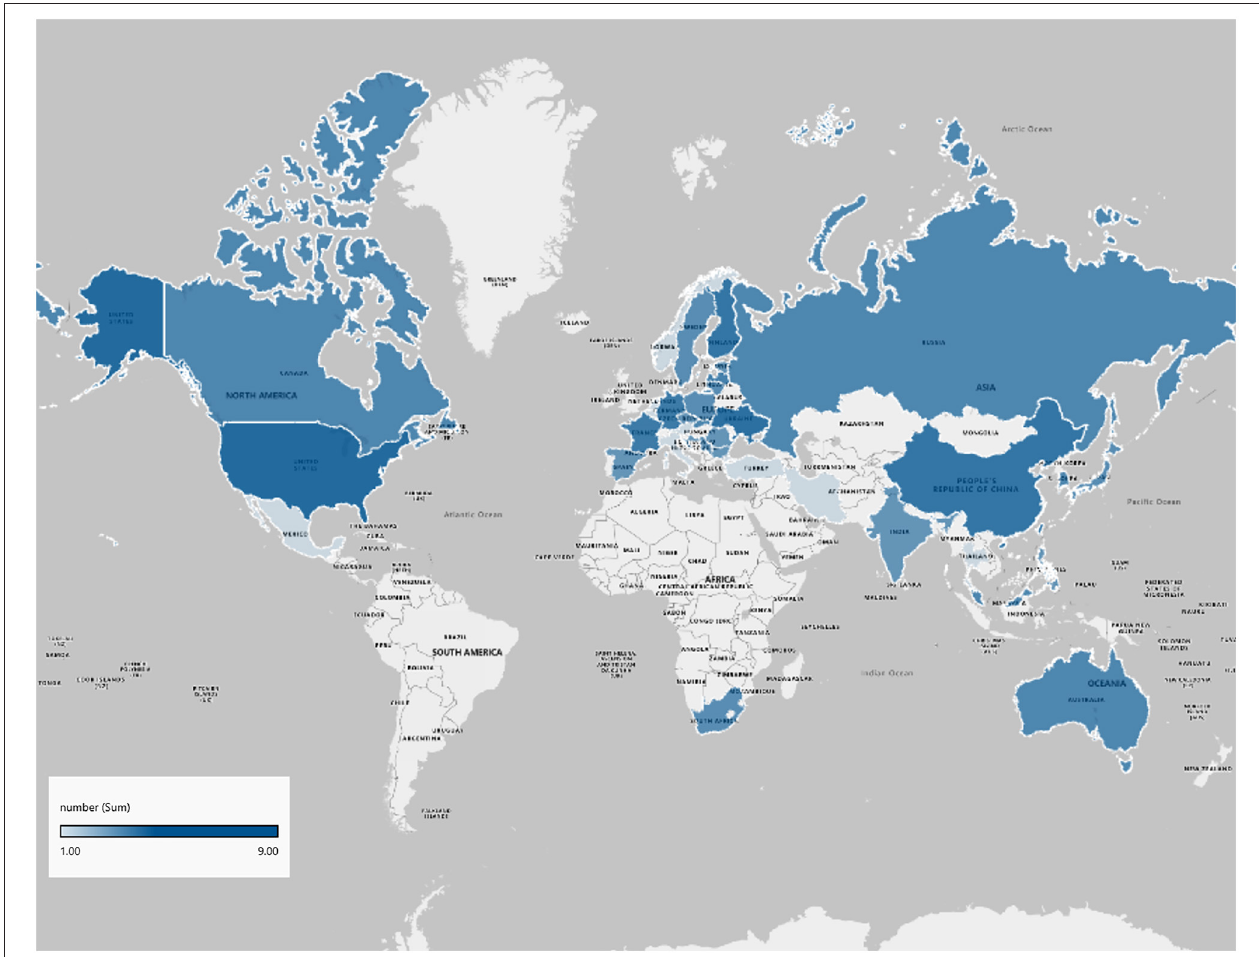
FIGURE 2 | Countries participating in